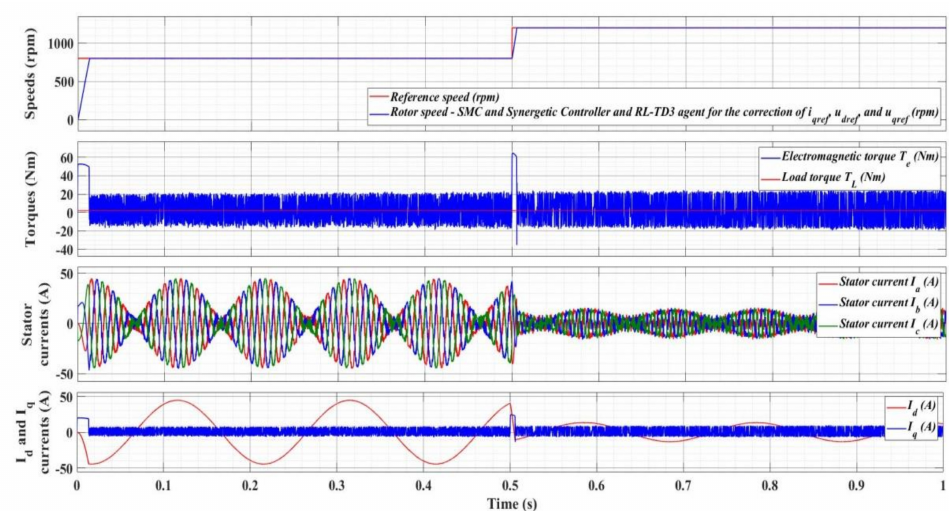
Figure 39. Time evolution for the numerical simulation of the PMSM control system based on control using SMC and synergetic controllers using an RL-TD3 agent for the correction of u dref , u qref , and i qref : T L = 2 Nm with 0.2 Nm magnitude of uniformly distributed noise and 50% increase in J parameter.